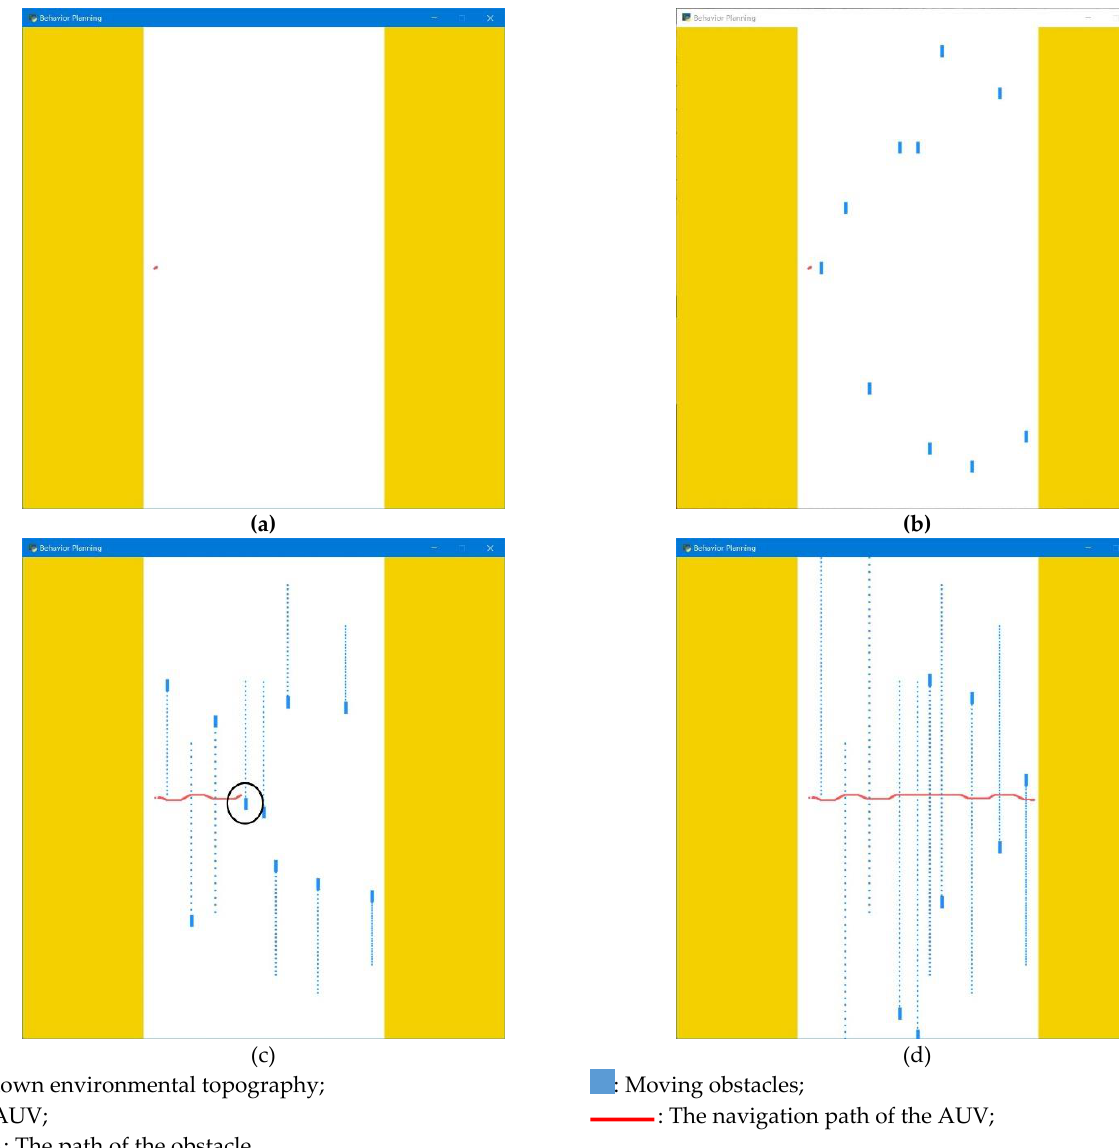
Figure 8. Motion planning of transversal crossing in waterway. ( a ) marine environment, ( b ) moving obstacle, ( c ) obstacle avoidance, ( d ) end of the test.